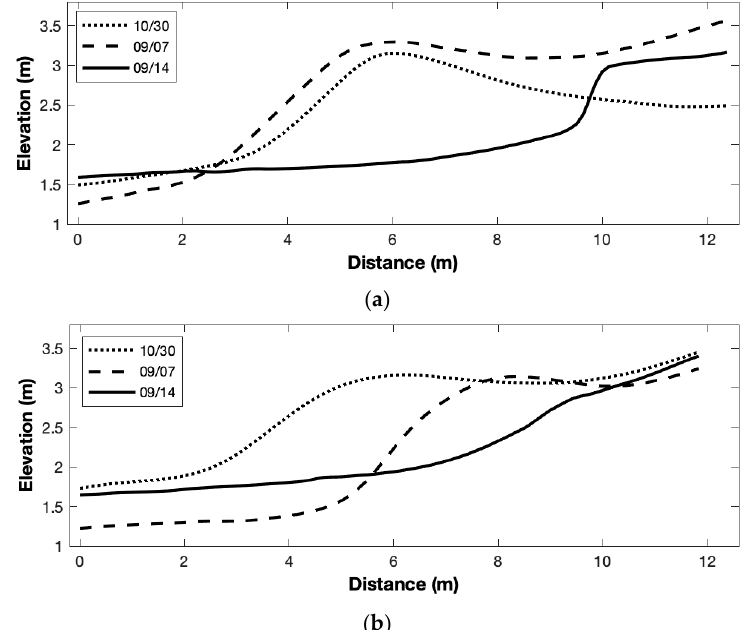
Figure 7. Topographic profiles from the mechanical and natural dune obtained during the first survey (10/28), the most recovered profile, which is also the pre-Hurricane Irma survey (09/07), and the post-Irma (09/14) survey. Representative profiles are shown from the natural ( a ) and mechanical ( b ) dunes. The elevation information for the profiles were obtained from the DEMs created for each survey.